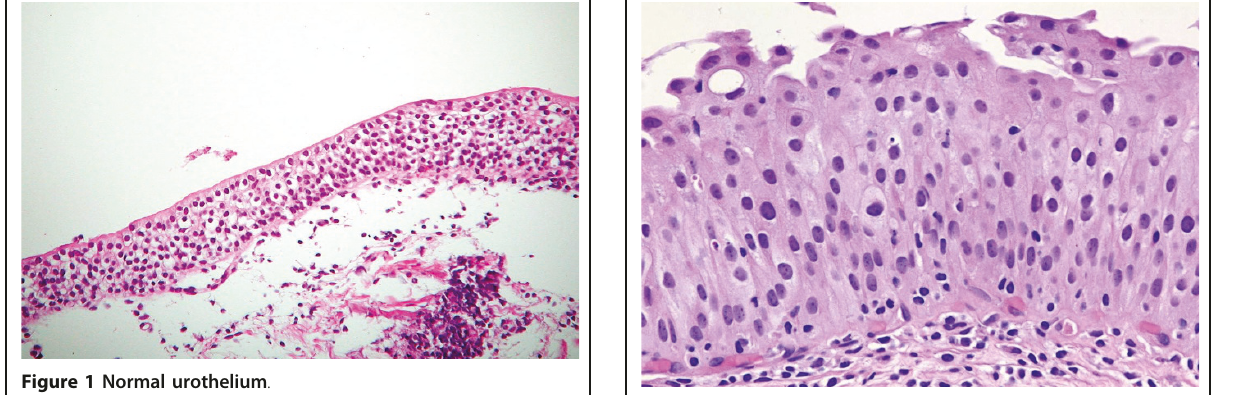
Figure 2 Flat urothelial hyperplasia .